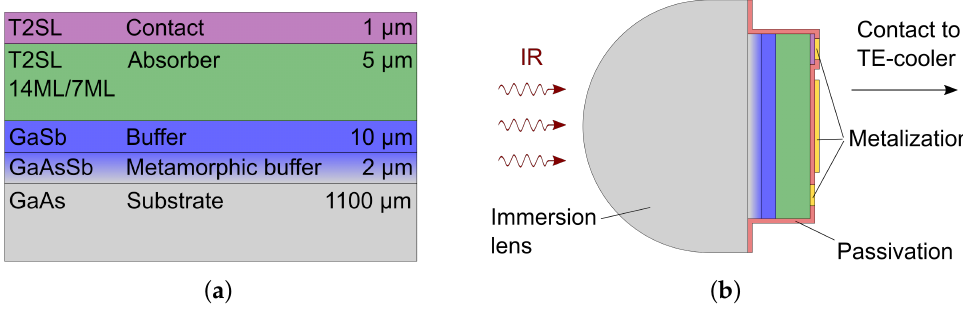
Figure 2. ( a ) Epitaxial layer structure for the fabrication of laterally-operated InAs / GaSb type-II superlattice (T2SL) detectors on GaAs substrate. ( b ) Schematic of a processed InAs / GaSb T2SL detector that is backside-illuminated through an immersion lens (not to